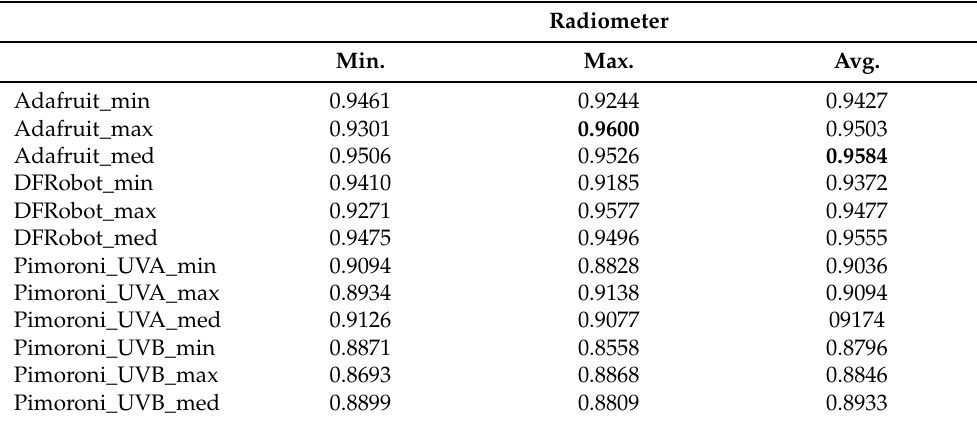
Table 1. Correlation degree of the data captured by the sensors and the pattern reference provided by the